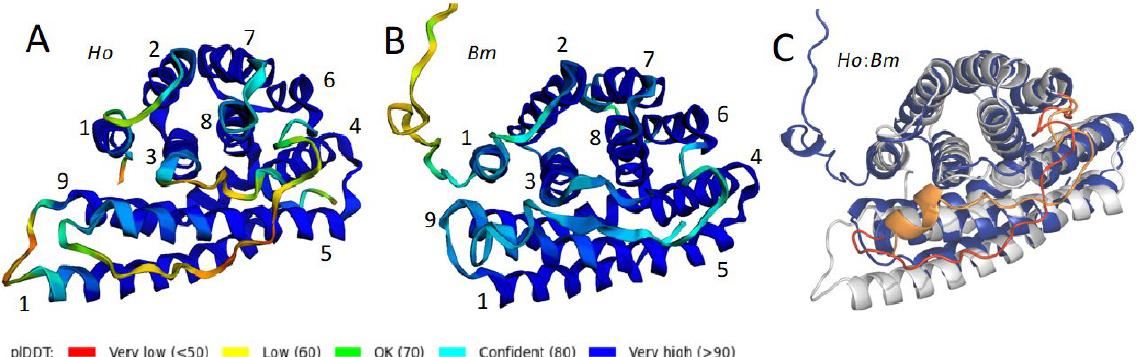
Figure 2. ColabFold predicted L-fib structures color-coded by pLDDT. Helices are numbered. ( A ) H. occidentalis ( Ho ). ( B ) B. mori ( Bm ). The helices have been numbered consecutively from the N-termini. ( C ) Overlay of Ho (gray) and Bm (blue) ColabFold structures. The unstructured loops connecting H5 and H6 are shown in orange ( Bm ) and red ( Ho ) for better visibility. See Supplemental Video 1 (SV1) to examine more orientations of the overlaid